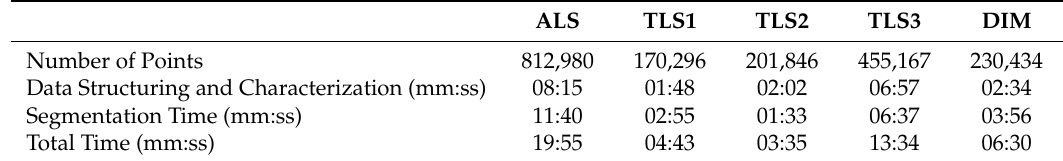
Table 2. Time performance of the proposed segmentation.